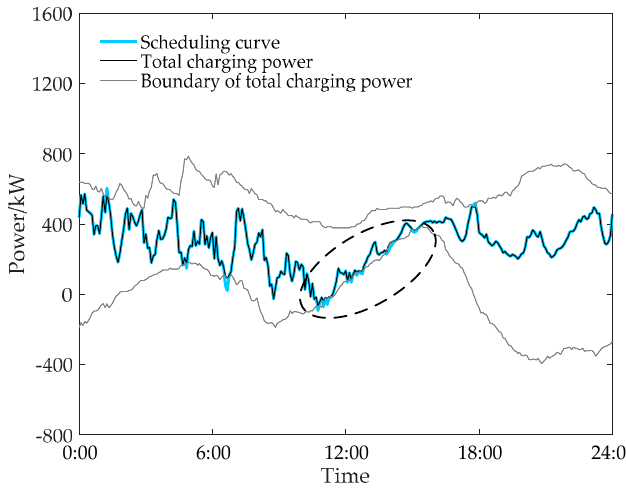
Figure 11. Scheduling power and total charging power.